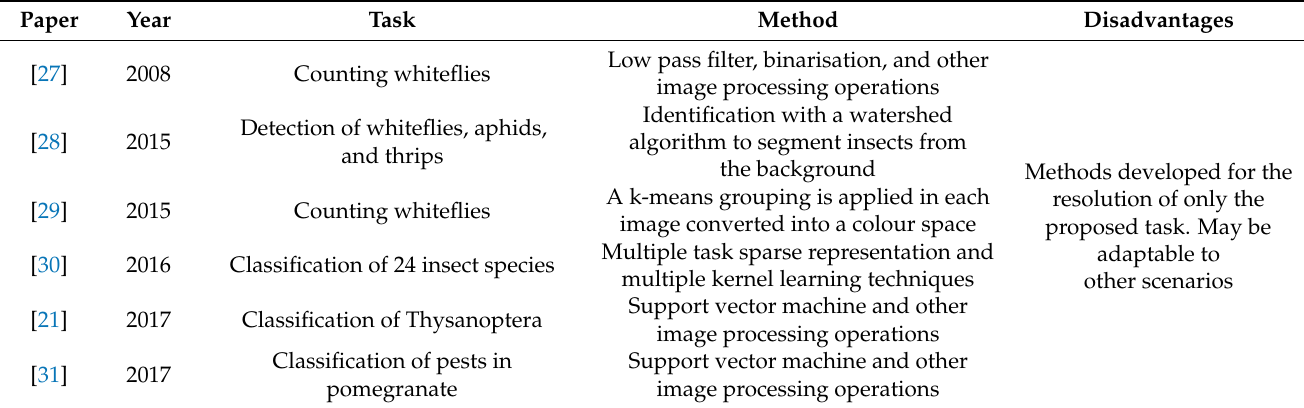
Table 1. Study analysis based on image processing and ML techniques.